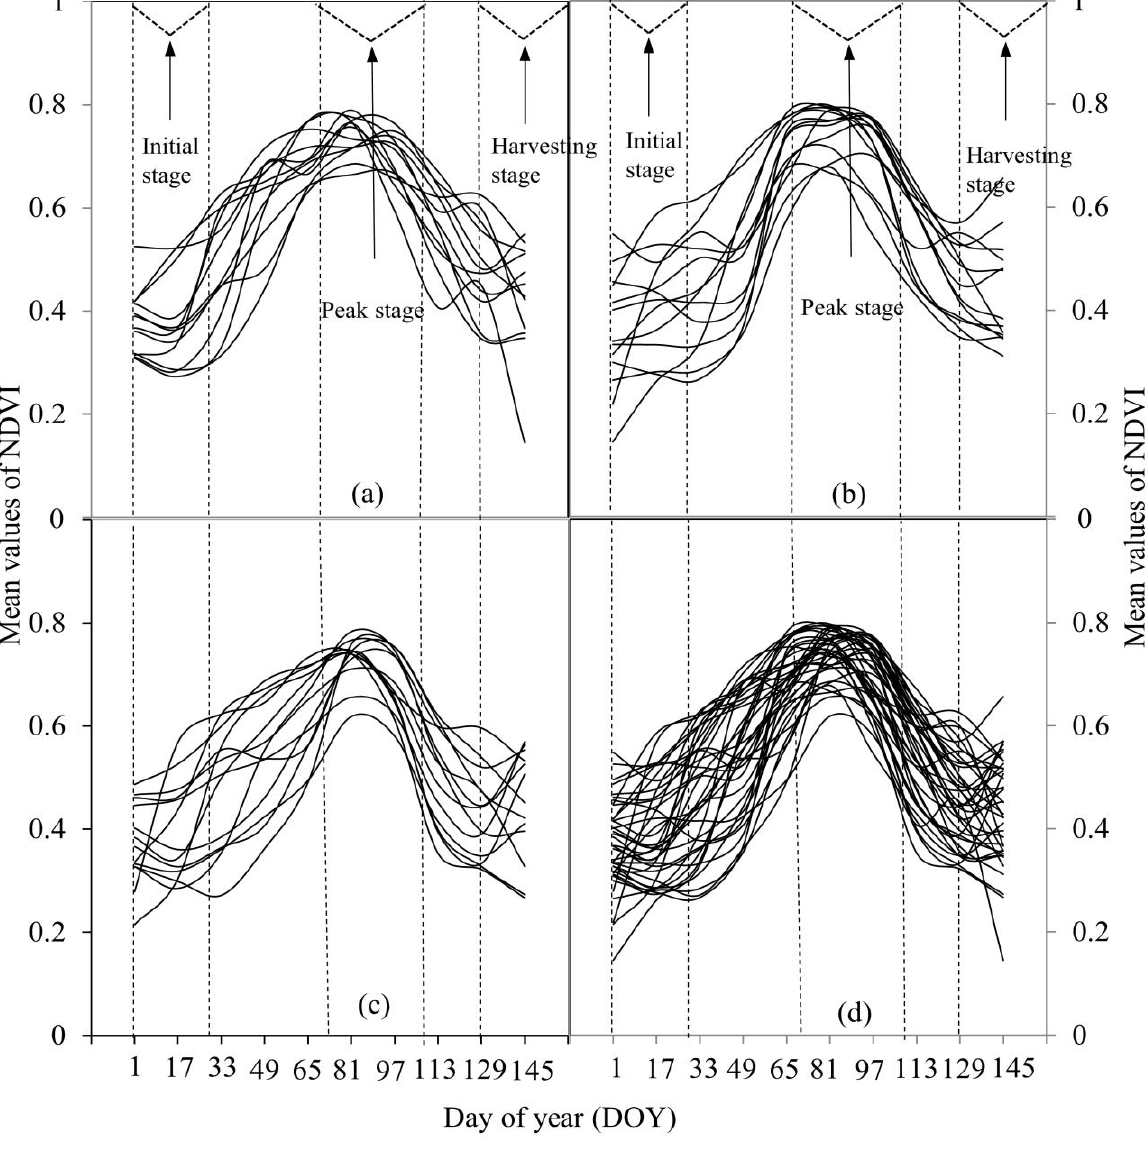
Table 2. Determination of optimal value of multiplier illustrated in Equations (5) and (6) during 2007–2009 at the country-level boro rice cultivation